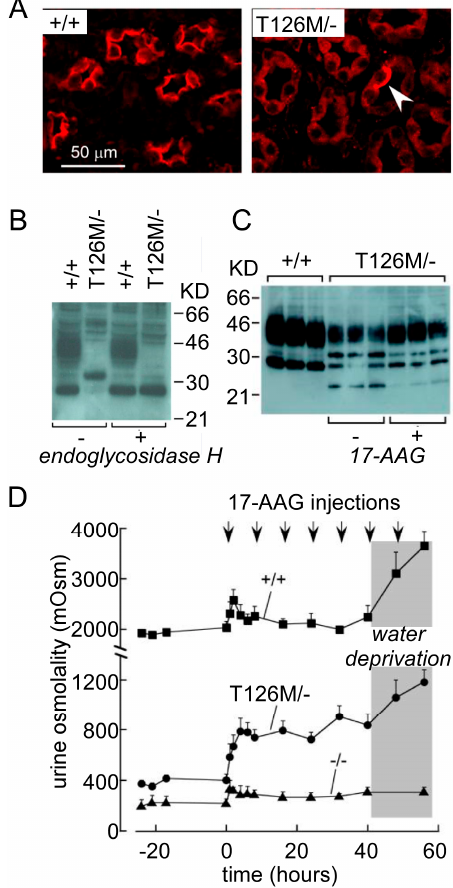
Figure 3. NDI caused by AQP2 mutation. ( A ) The immunofluorescence of AQP2 in kidneys of wild-type (left) and inducible AQP2 T126M/ − mice (right). ( B ) Immunoblot of AQP2 from wild-type and inducible AQP2 T126M/ − mice. ( C ) AQP2 protein immunoblot of kidney homogenates from wild-type and AQP2 T126M/ − mice treated with or without Hsp90 inhibitor 17-AAG. ( D ) Urine osmolality in wild-type, AQP2 knockout, and inducible AQP2 T126M/ − mice given free access to food and water before and after 17-AAG treatment. The block, solid ball, and triangle represent wild-type mice, AQP2 T126M/ − mice, and AQP2 − / − mice, respectively (adapted from Ref [38]).